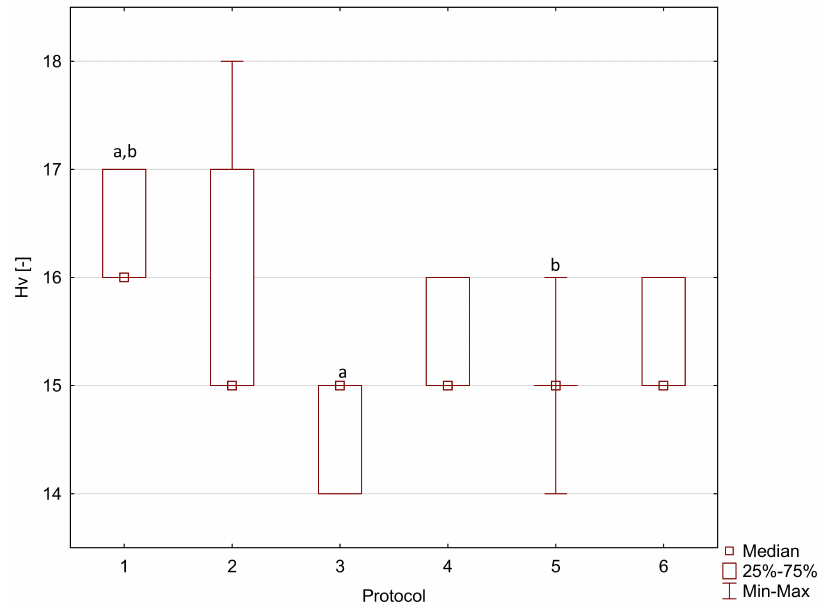
Figure A3. Box-and-whisker plot of Vickers hardness (HV) of Resin F material. Statistically-significant differences were detected between the following: (a,b) Protocol 1 (water, 24 h, 37 ◦ C) vs. (a)